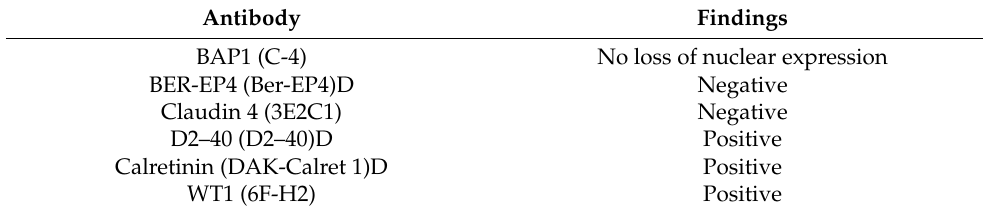
Table 1. Immunohistochemical tests results.